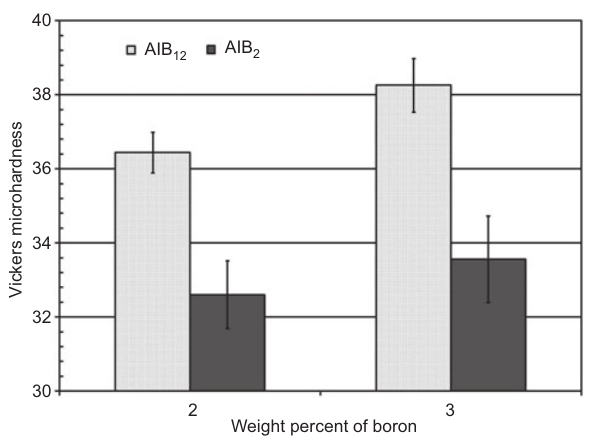
Figure 3 Vickers matrix microhardness of centrifugally cast Al-B-Si composites.